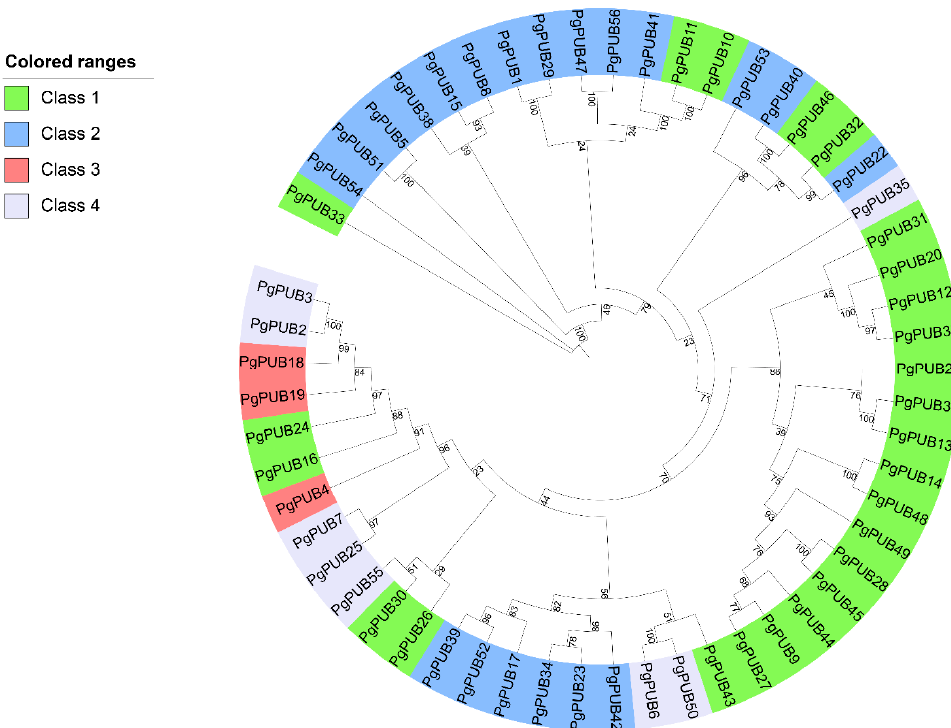
Figure 1. Phylogenetic tree analysis of 56 U-box genes in pomegranate using the maximum-likelihood method with 1000 bootstrap values. The numbers indicate the bootstrap values as a percentage of trees obtained from 1000 replicates. The different colors indicate different U-box classes.